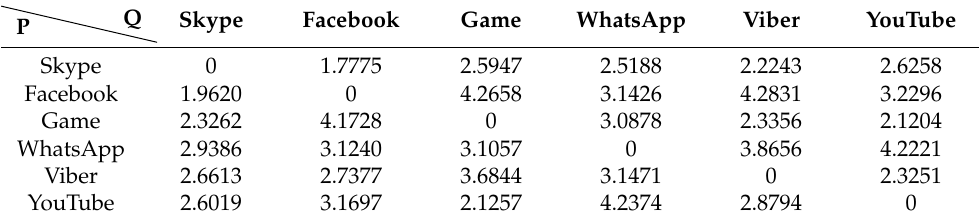
Table 13. Kullback–Leibler divergence of packet lengths